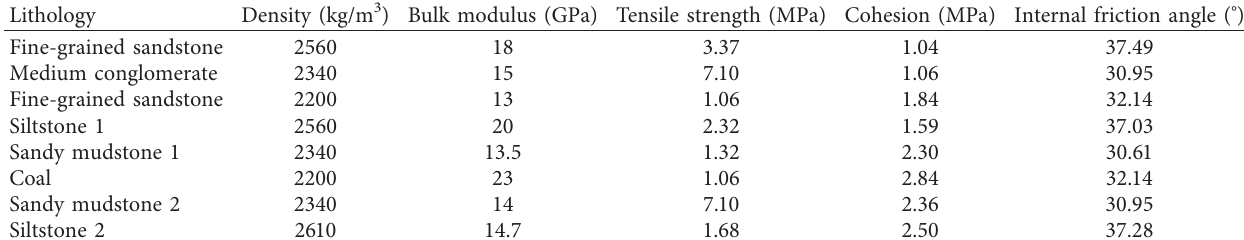
Table 4: Modeling parameters of rock.